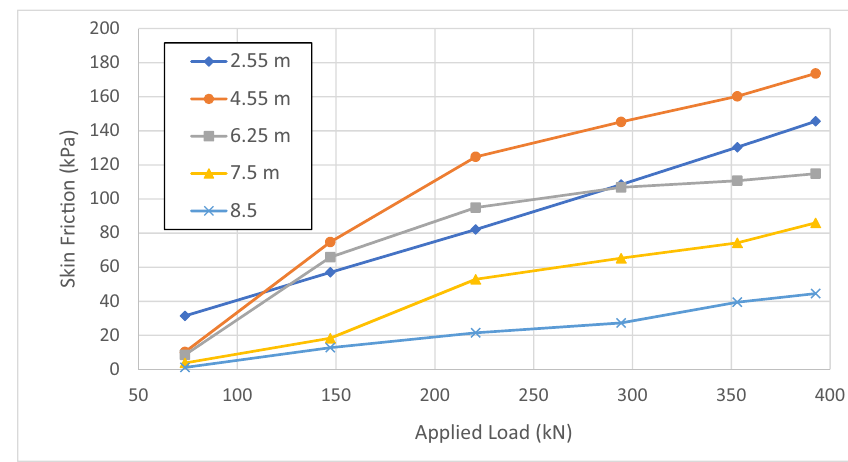
Figure 23: Mobilized skin friction at mid - distance between the measurement